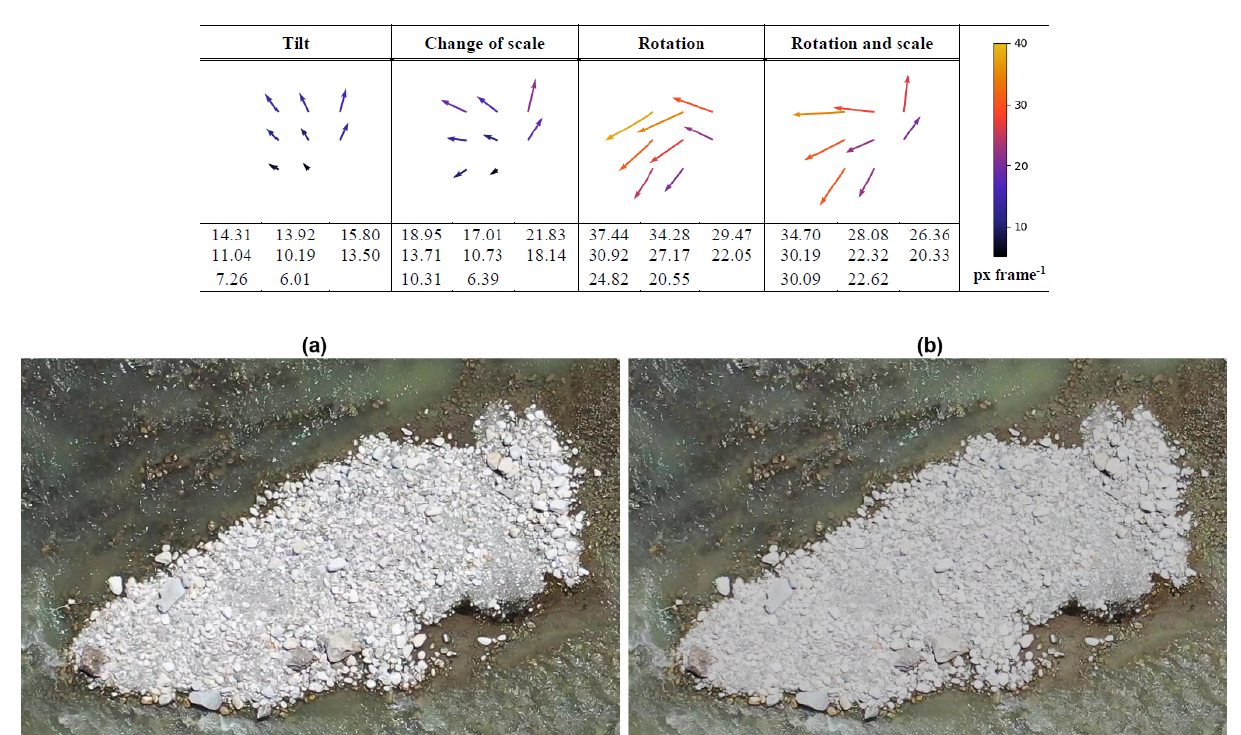
Table 2. Aggregated results of the SVF analysis of the unstabilised video for the Kolubara case study. The mean u and v components of the apparent motion of static features in eight subregions are illustrated by vector size and orientation, whereas numeric values illustrate the mean apparent velocity magnitude for each subregion.